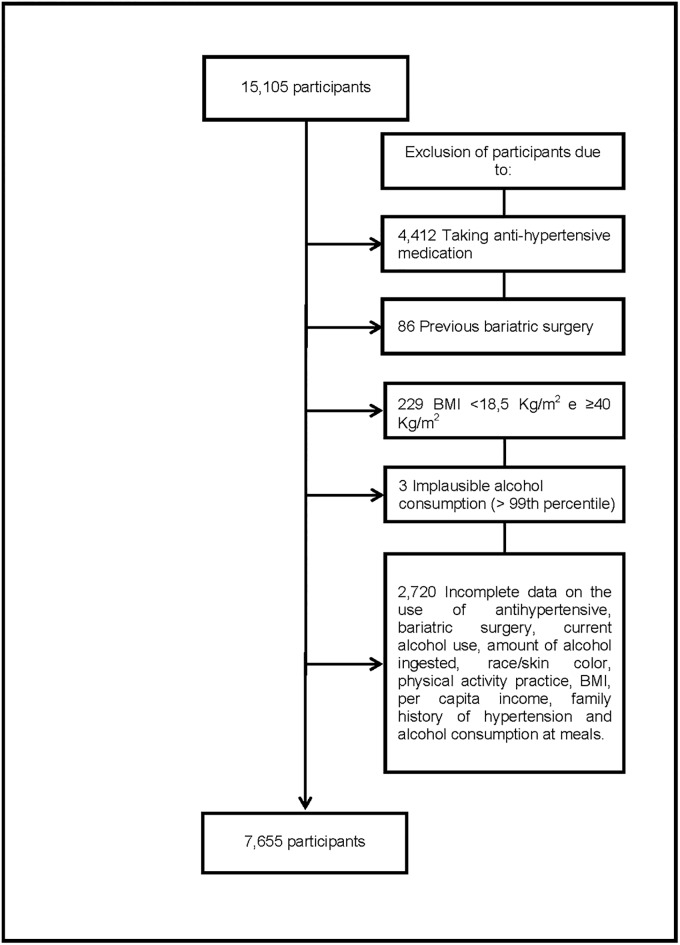
Participants exclusion flowchart.